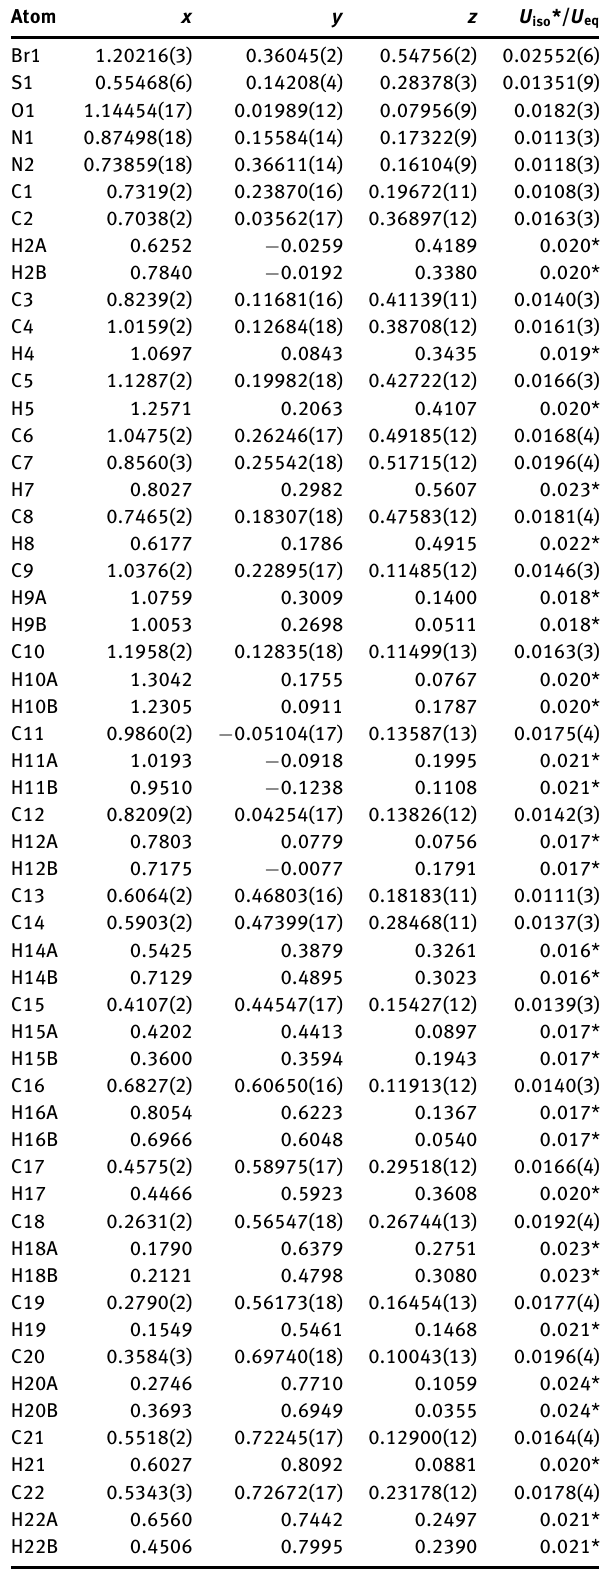
Table 2: Fractional atomic coordinates and isotropic or equivalent isotropic displacement parameters (Å 2